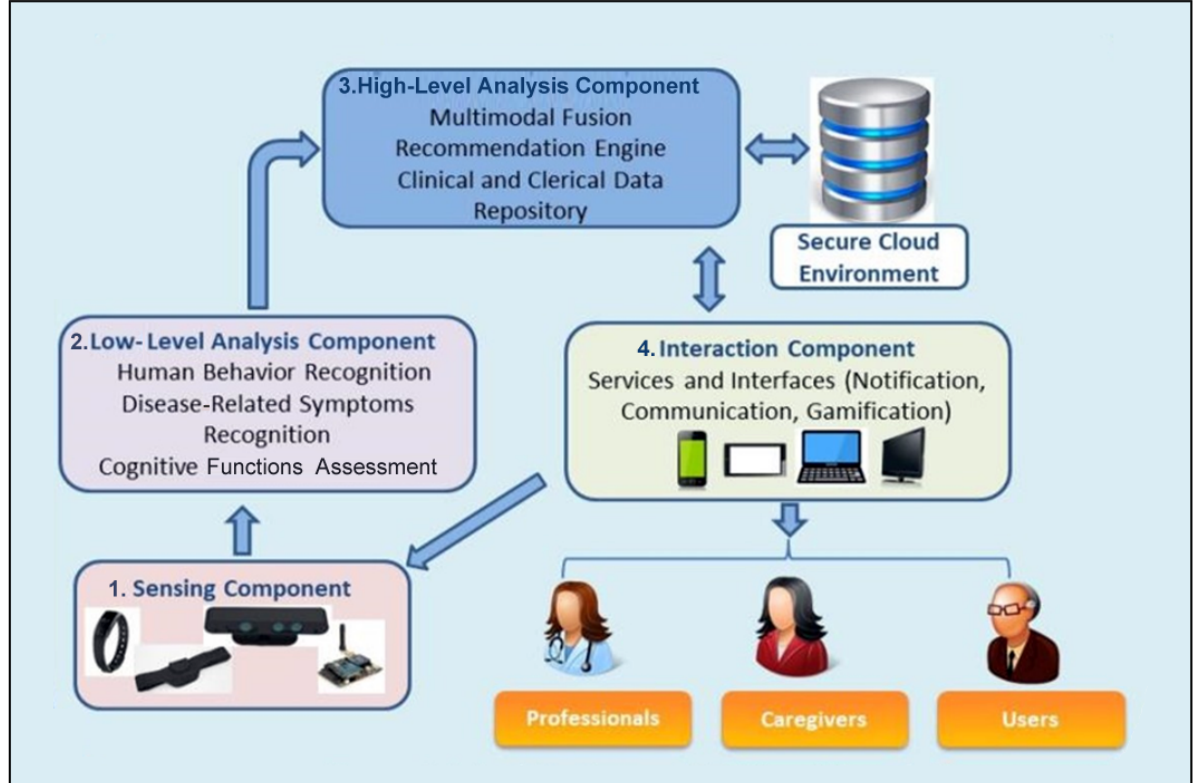
Figure 1. Technology of the PROCare4Life platform (source: PROCare4Life grant agreement, funded by The European Commission). PROCare4Life: Personalized Integrated Care Promoting Quality of Life for Older